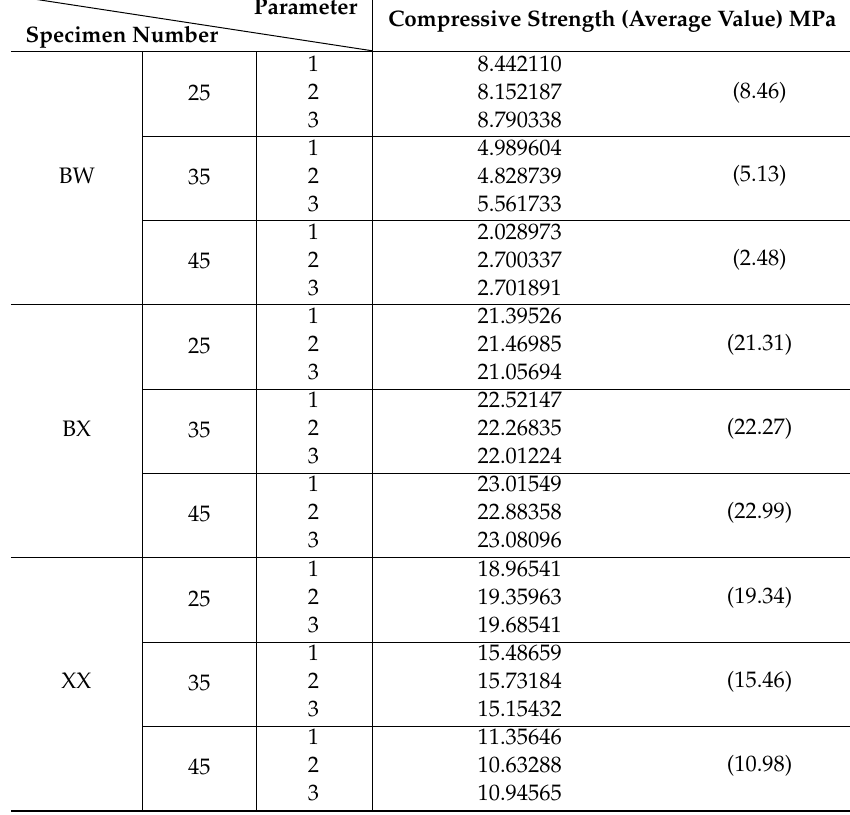
Table 12. Summary table of compressive strength measurement data.